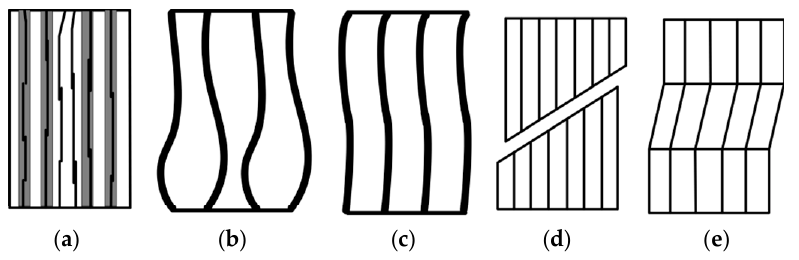
Figure 5. Compression failure mode of unidirectional composites [65]. ( a ) Matrix failure; ( b ) fiber reverse buckling; ( c ) fiber synthetic buckling; ( d ) fiber shear failure; ( e ) fiber shear buckling.